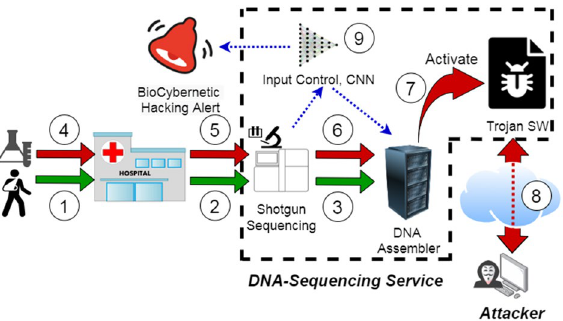
Figure 1. Hybrid Trojan Bio-Cyber Hacking Attack. Steps 1–3 indicate a typical genetic sequencing operation for patients. Steps 4–6 indicate a situation where a hacker has embedded their IP address and Port number into a DNA that will trigger a remote connection from a Trojan-horse infected software tool leading to a connection to the attacker in Step 8. Our proposed approach utilizes Deep-Learning to detect Trojan payload in digital data using encoded into DNA strands that can prevent the attack. (The image is drawn using